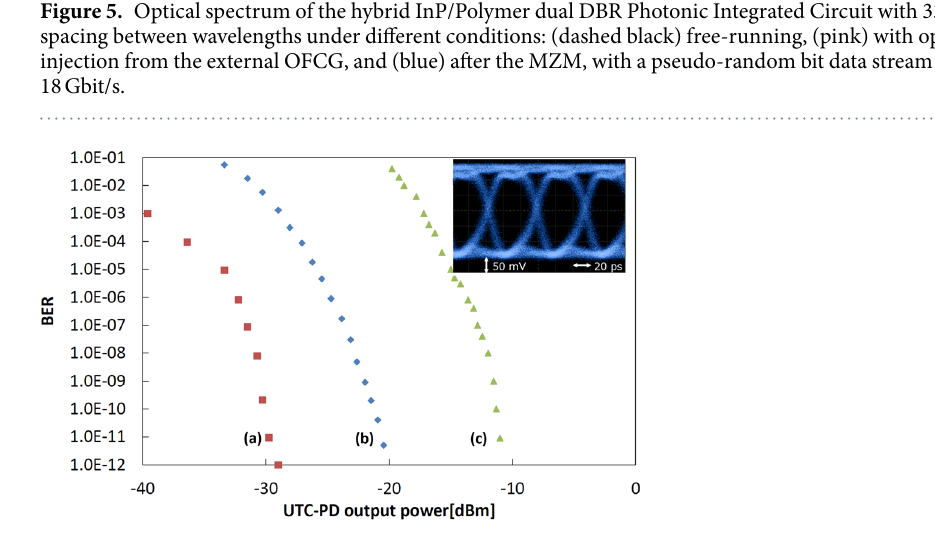
Figure 6. Bit error rate (BER) characteristics at 18 Gbit/s generating the 330 GHz carrier from: ( a ) an actively phase stabilized reference source 18 , ( b ) the dual hybrid InP/Polymer DBR with − 8 dBm optical injection power from the OFCG, and ( c ) free-running dual hybrid InP/Polymer DBR lasers and using direct detection at receiver. The inset shows the eye diagram under conditions of ( b